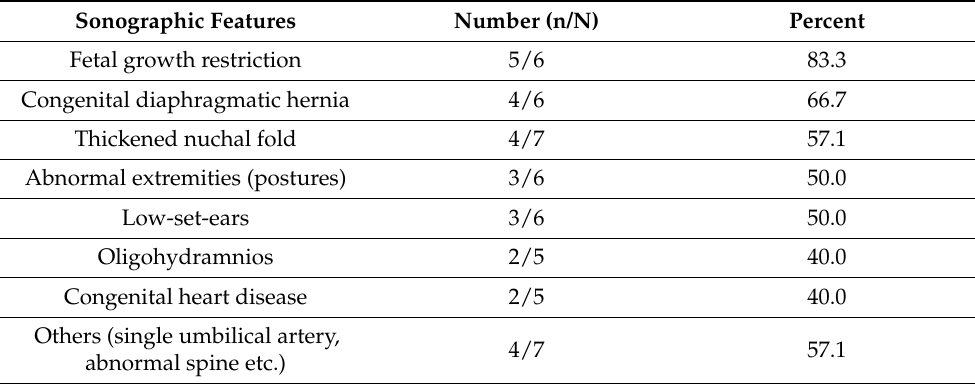
Table 2. Common prenatal sonographic features of 7 fetuses with ring chromosome 15 (not included are the abnormalities unlikely to be detected by ultrasound